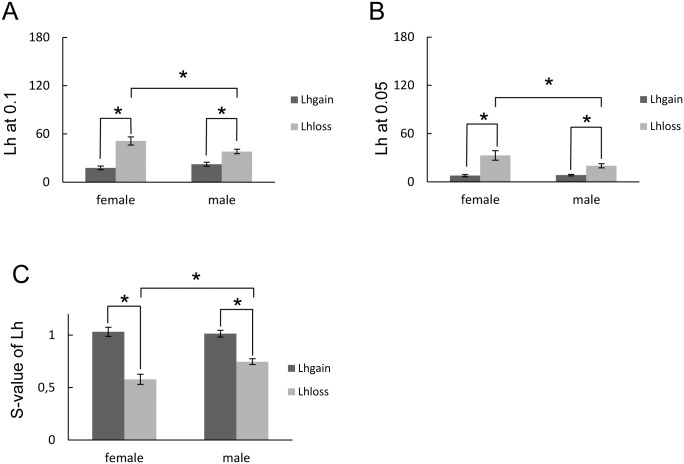
Subjective likelihood of gain and loss.Lh at a probability of (A) 0.1 and (B) 0.05. (C) s-vales of the Lhgain and Lhloss in each sex. * P < 0.05, post-hoc Holm multiple comparisons following ANOVA. Data are expressed as mean ± SEM. Vertical axis: a 180-mm scale of the paper–pencil task.